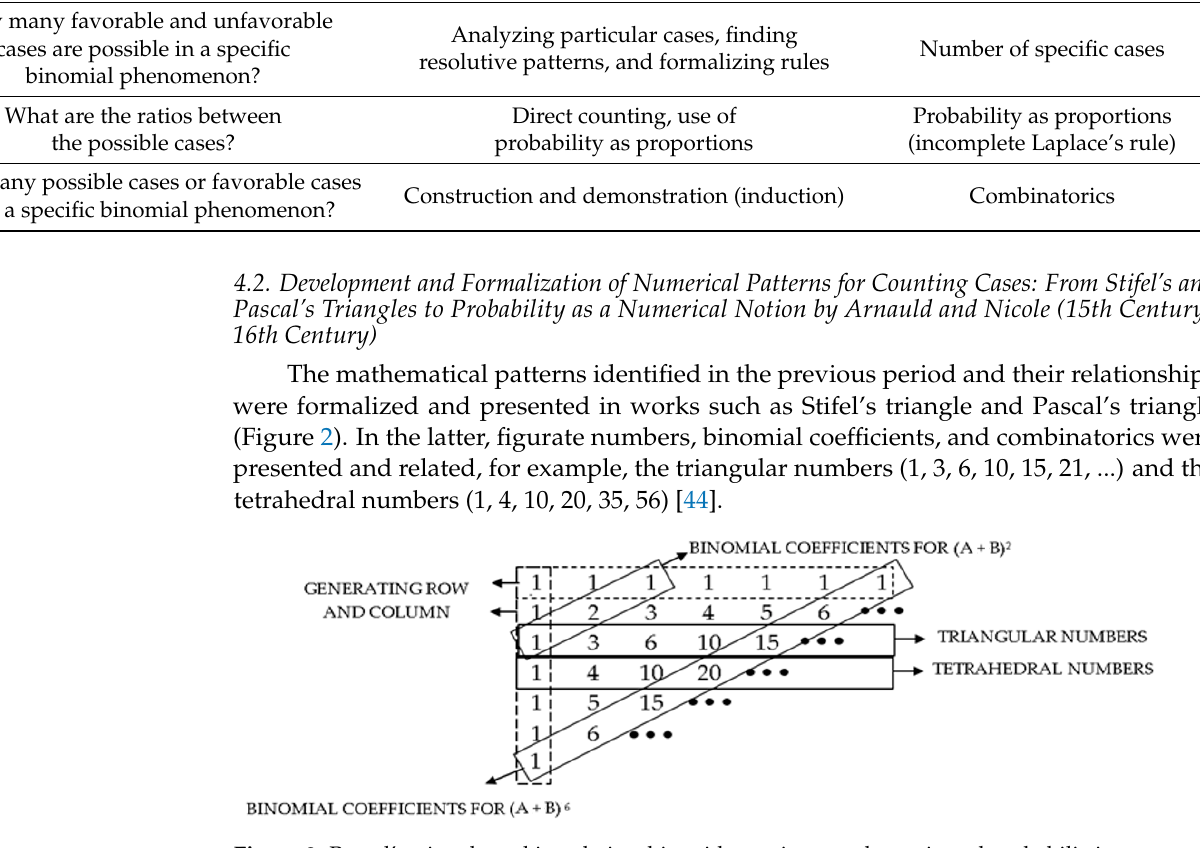
Figure 2. Pascal’s triangle and its relationship with previous mathematic and probabilistic constructs (adapted from [42]).